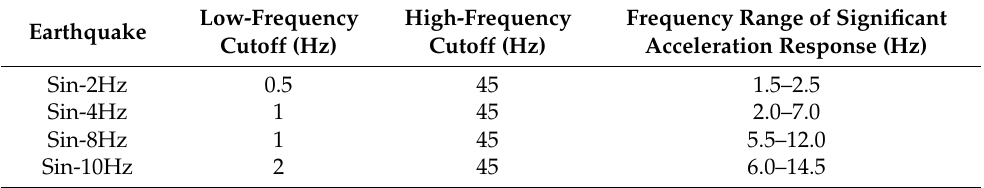
Table 5. Characteristics of the filters used in data